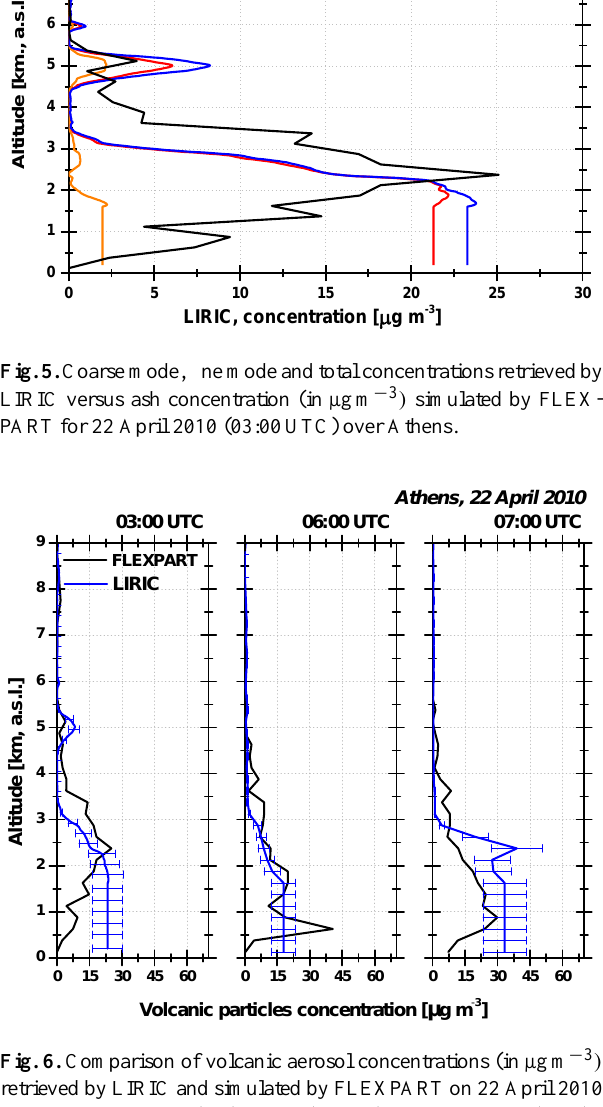
peaked up to 52 µg m − 3 around 2.1 km at 03:00 UTC; the simulated concentrations by FLEXPART gave a mean value of 8.8 ± 0.7 µg m − 3 with a peak value around 25.1 µg m − 3 around 2.4 km at 03:00 UTC. The coefficient R 2 between the FLEXPART and LIRIC profiles ranged from 0.69 (at 03:00 UTC) to 0.84 (at 06:00 UTC), while it remained lower (0.74) at 07:00